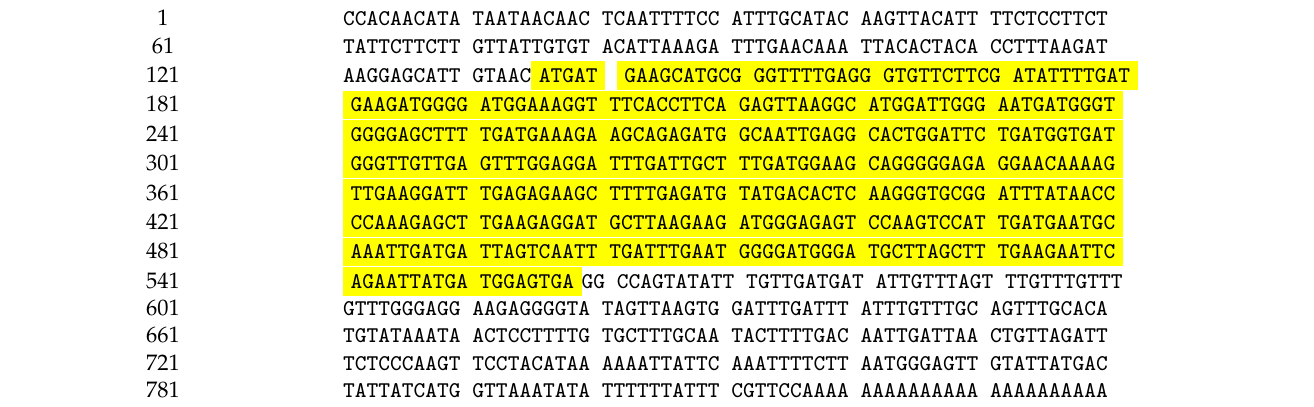
Table 1. The nucleotide sequence of MpCML40 cDNA. The open reading frame (ORF) of MpCML40 is highlighted in yellow.